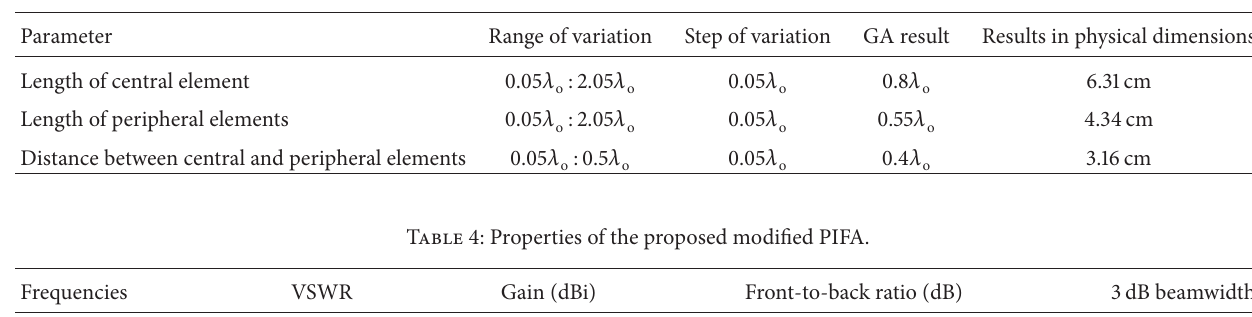
Table 3: Input parameters and results of the GA optimization procedure for the 5-element circular switched parasitic element with two active elements.